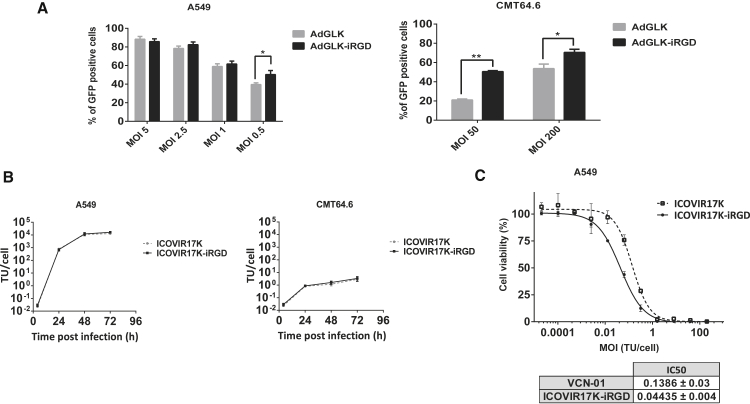
In Vitro Characterization of iRGD-Modified Adenoviruses(A) The cell lines A549 and CMT64.6 were infected with the indicated GFP-expressing vectors at different MOIs, GFP was measured after 24 hr by flow cytometry, and the percentage of GFP-positive cells is plotted for each vector. The vectors share the same expression cassette containing GFP and luciferase transgenes. Mean ± SD error bars are plotted. Significant difference between the vectors (*p < 0.05, **p ≤ 0.01) was calculated by two-tailed unpaired Student’s t test. (B) Viral production of ICOVIR17K-iRGD. A549 and CMT64.6 cells were infected with ICOVIR17K or ICOVIR17K-iRGD at the indicated time points, and cell extracts were harvested and titrated. Three replicates were quantified for each cell line. Mean ± SD of triplicates is shown. (C) Comparative cytotoxicity in vitro of ICOVIR17K and ICOVIR17K-iRGD. A549 cells were infected with the indicated viruses at doses starting from 200 TU/cell. IC50 values (TU per cell required to cause a reduction of 50% in cell culture viability) at day 6 after infection are shown. Four replicates were quantified. Mean ± SD of triplicates is shown.